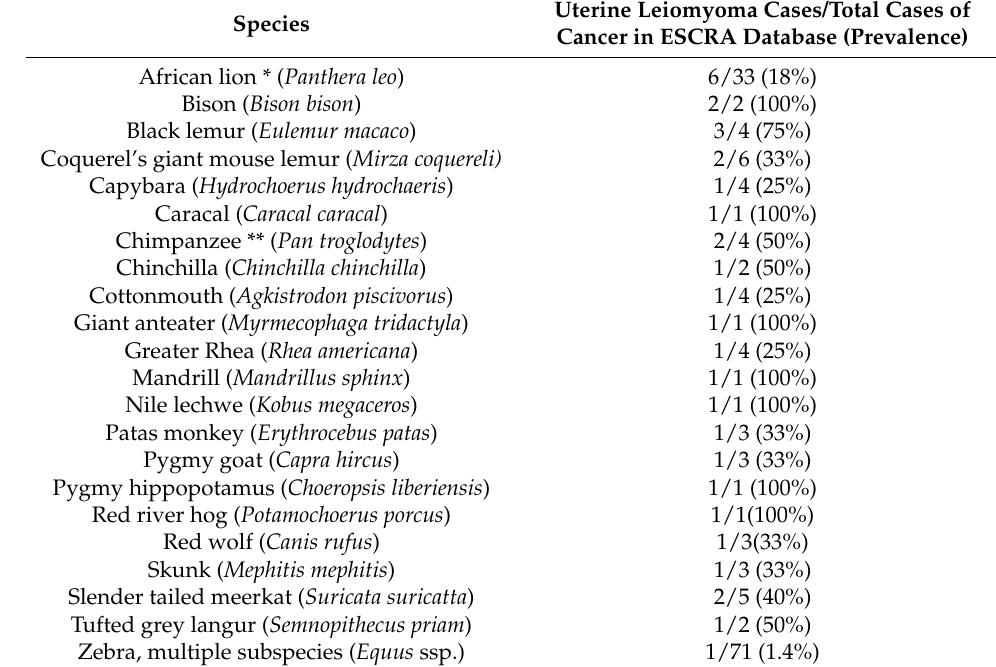
Table 3. Prevalence of uterine leiomyomas among animals reported to the Exotic Species